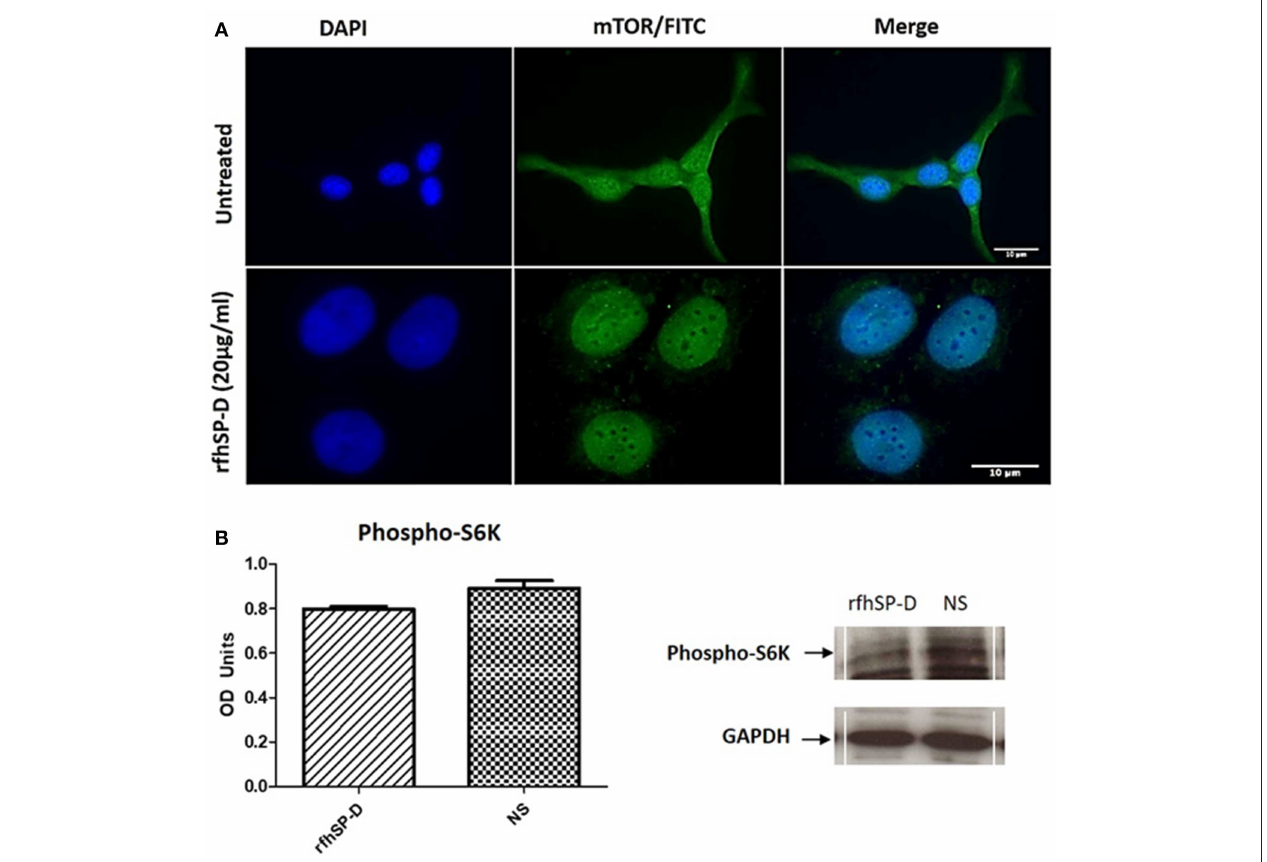
FIGURE 10 | Assessment of mTOR localization in SKOV3 cells. (A) rfhSP-D treatment downregulated the survival pathway, mTOR. Fluorescence microscopy analysis following rfhSP-D (20 ug/ml) treatment of SKOV3 cells showed reduced cytoplasmic levels of mTOR following treatment as compared to the untreated. Nuclear accumulation of mTOR was seen in the treated cells. (B) Effects of rfhSP-D on phospho (Thr389) p70S6K in SKOV3 cells treated with rfhSP-D (20 µ